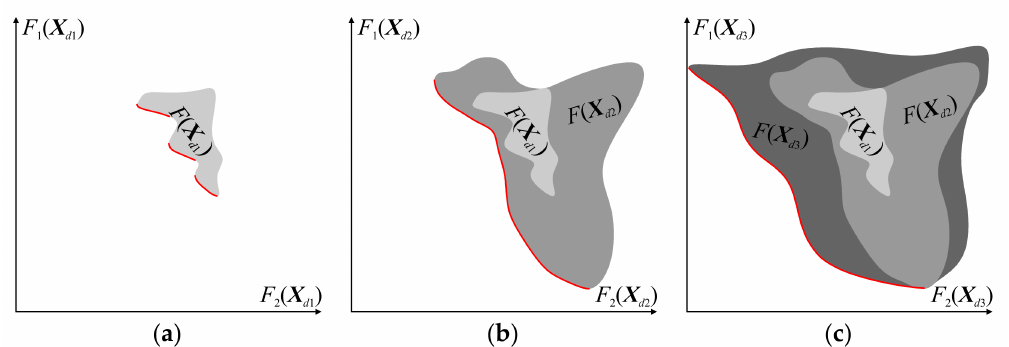
Figure 2. Conceptual illustration of the feature space for the bi-objective problem, characterized by a gradual increase of dimensionality. ( a ) d 1 , ( b ) d 2 > d 1 , and ( c ) d 3 > d 2 . The red line represents the Pareto front [39]. Note that the solutions that are attainable for the structure represented using, for example, d 1 variables, represent a subset of the responses that can be found when the dimensionality is